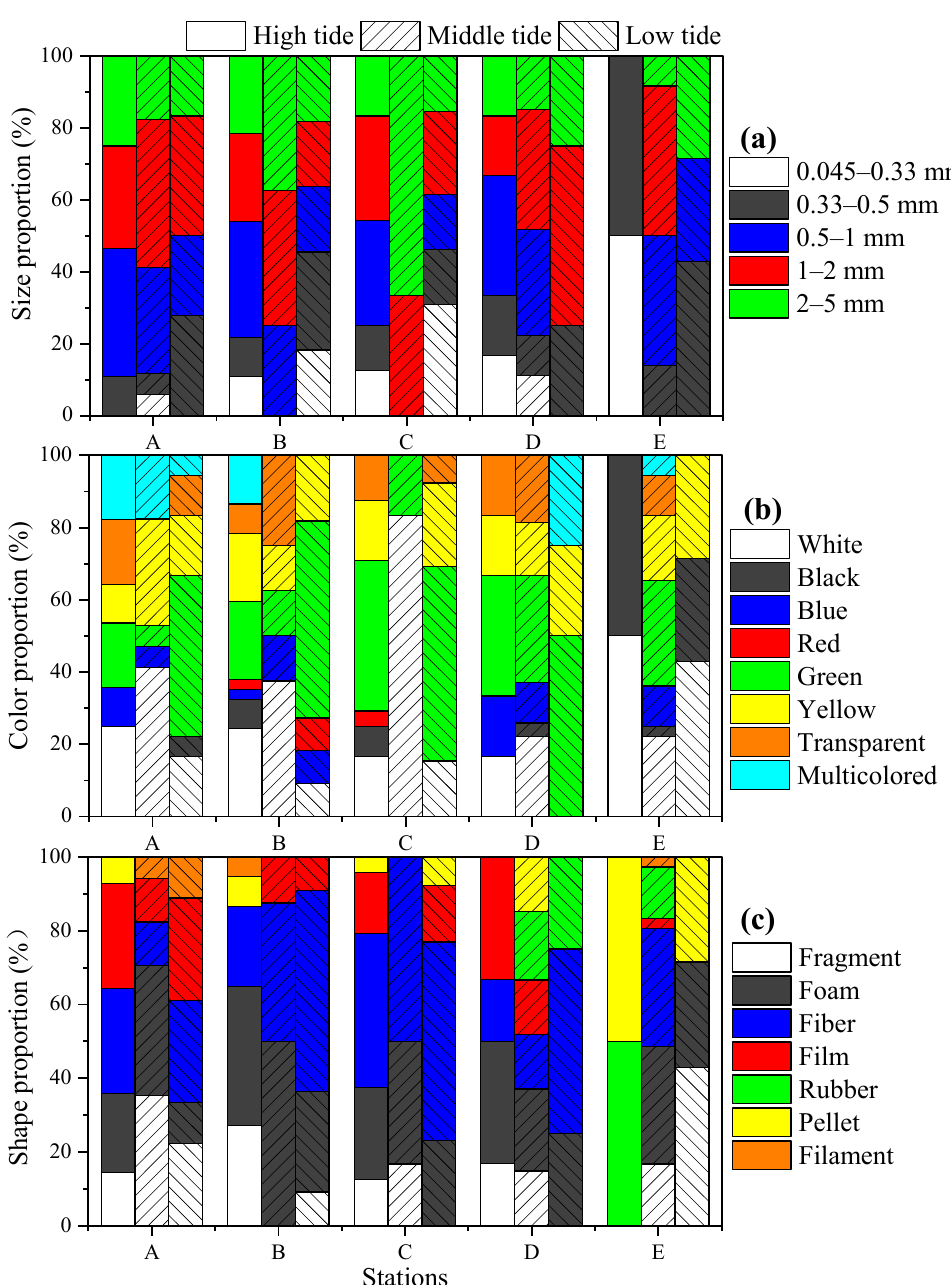
Figure 4. Sizes ( a ), colors ( b ), and shapes ( c ) of MPs in the bathing seawater affected by the ebb tide.